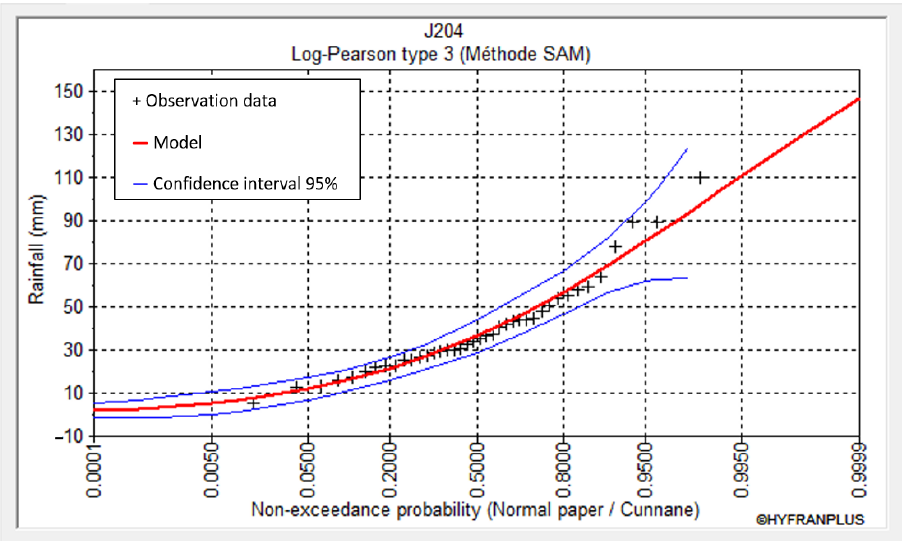
Figure 3. Gumbel fit of maximum daily rainfall of J204 station.